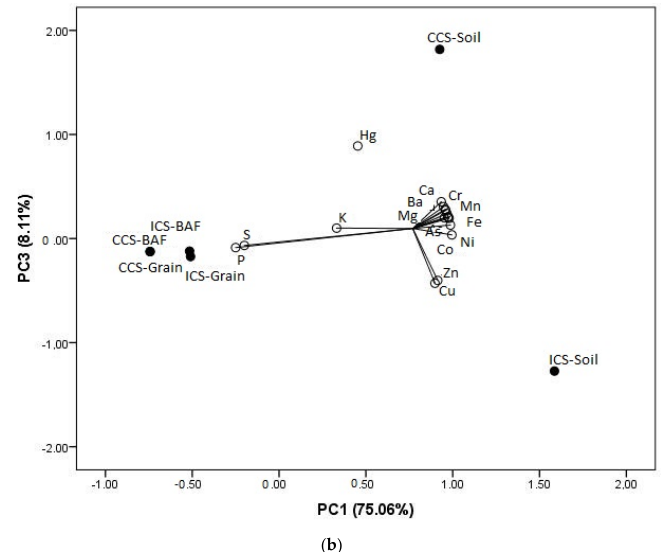
Figure 3. Principal component analysis (PCA) ( a ) PCA for elemental composition of soil under ICS and CCS; ( b ) PCA for elemental profile of the wheat grain grown in ICS and CCS.